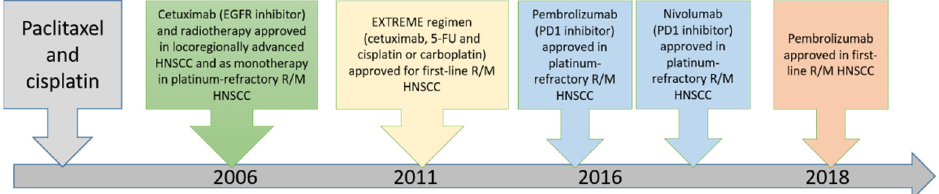
Figure 5. Timeline of major discoveries and related therapeutic approaches in head and neck squa- mous cell carcinoma. (R/M: recurrent/metastatic, HNSCC: head neck squamous cell